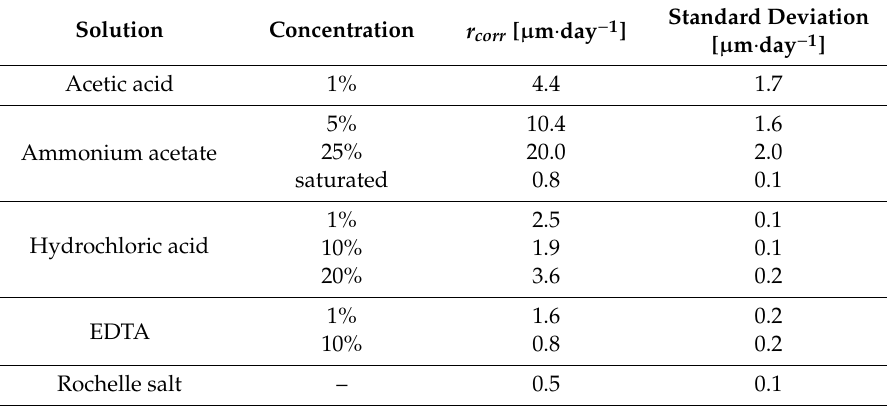
Table 6. Corrosion rates of freshly abraded lead in the tested